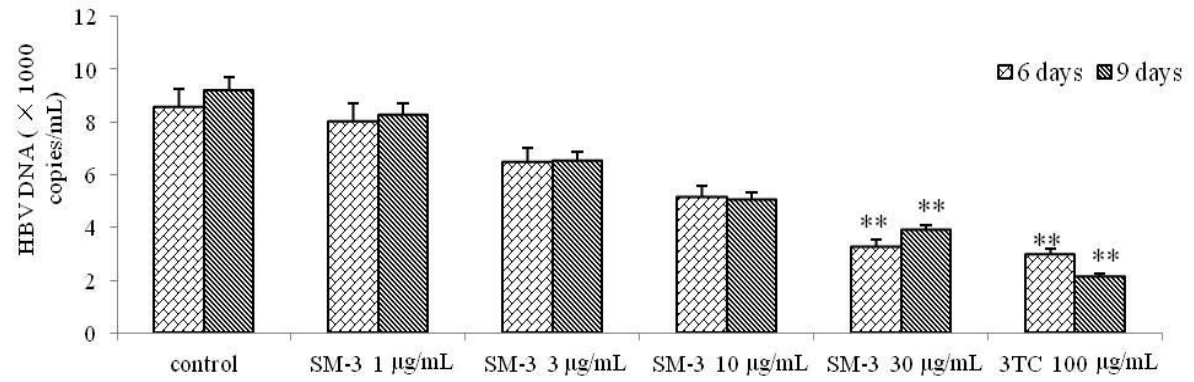
Figure 3. Inhibitory effect of SM-3 on HBV DNA levels in HepG2.2.15 cells.